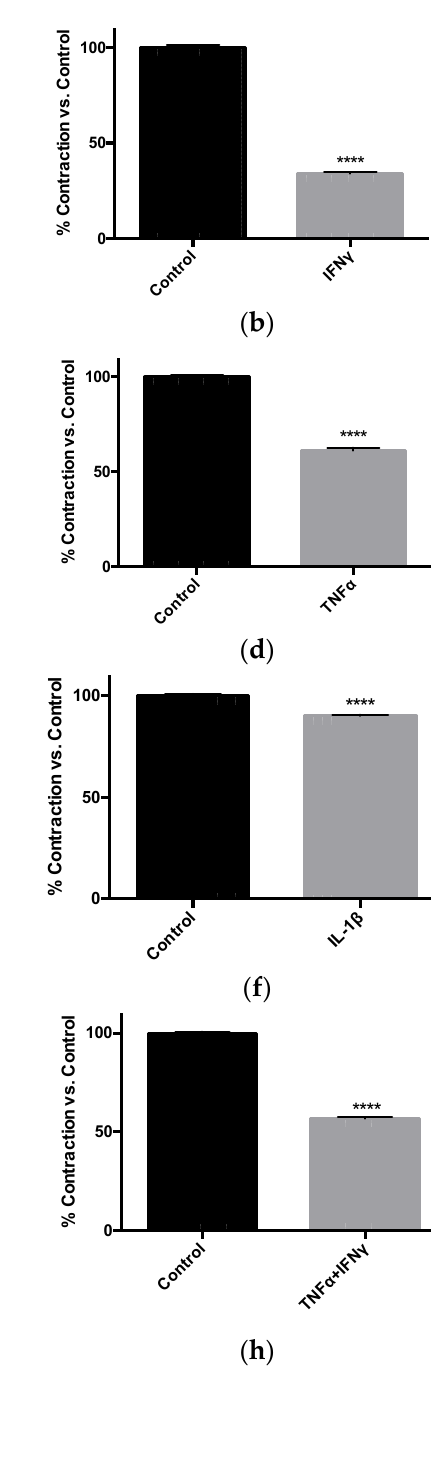
( b ) Figure 3. A β 25 ‐ 35 peptide enhanced HBVSMC contractility. ( a ) HBVSMC in collagen gel treated with various concentra ‐